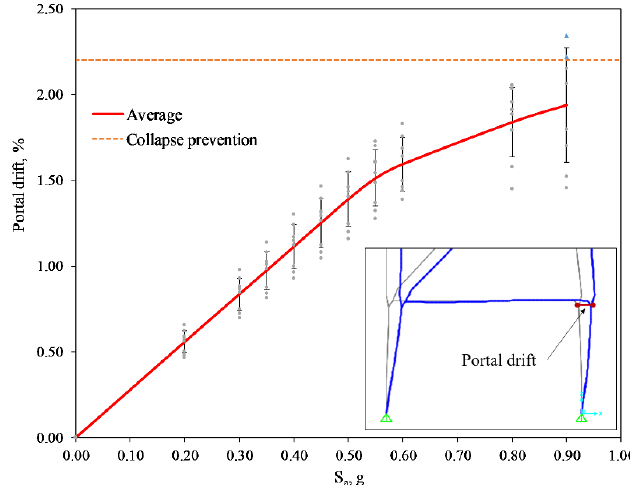
Figure 10. The portal drift of the PIN boundary condition.